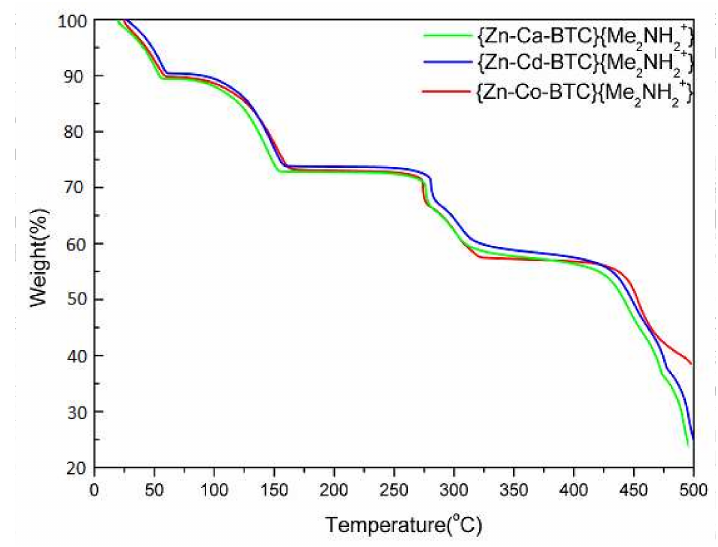
Figure 4. TGA curves of {Zn-M-BTC}{Me 2 NH 2+ } MOF (M = Co, Cd, Ca).